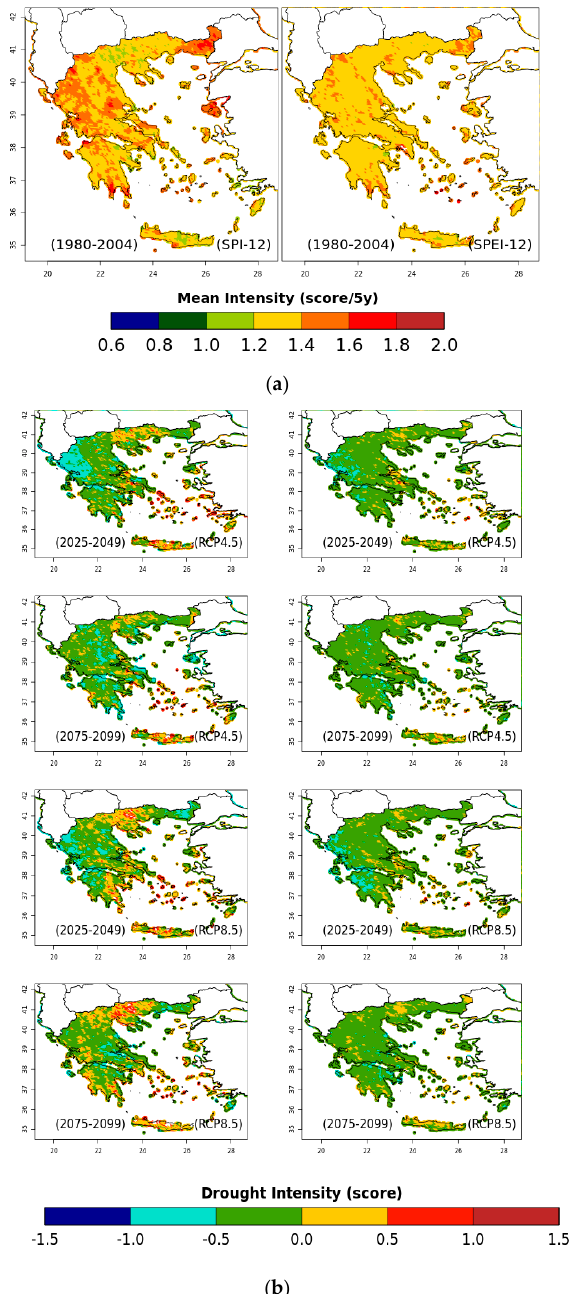
Figure 13. ( a ) Drought intensity as the number of events in 25 years for the reference period (1980– 2004) for the SPI and the SPEI indices computed at a 12 − month timescale. ( b ) Changes in the dura- tion for the 12 − months SPI and SPEI for the near future period (2025–2049) and the far future (2075– 2099) relative to the reference period (1980–2004) under RCP4.5 and RCP8.5.